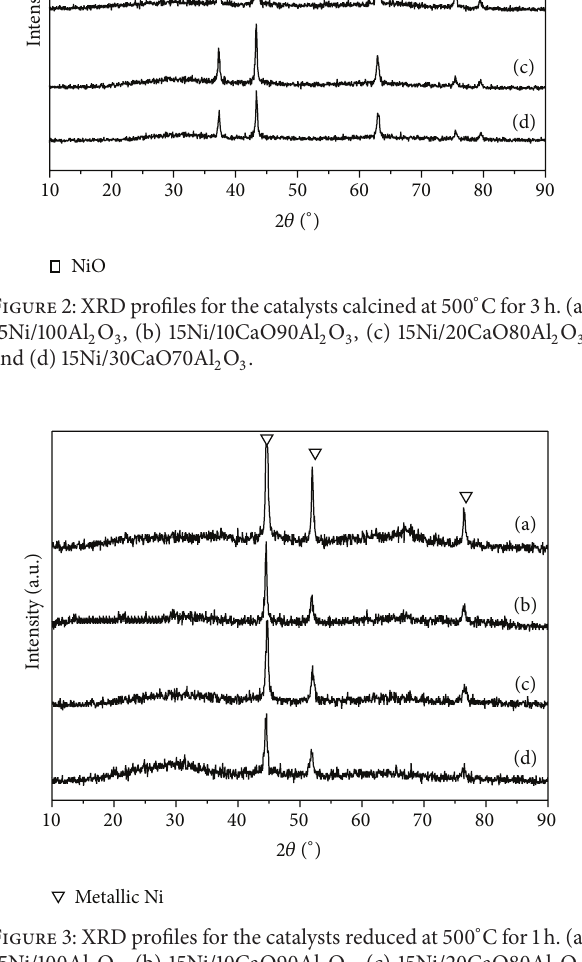
Figure 3: XRD profiles for the catalysts reduced at 500 ∘ C for 1h. (a) 15Ni/100Al 2 O 3 , (b) 15Ni/10CaO90Al 2 O 3 , (c) 15Ni/20CaO80Al 2 O 3 , and (d) 15Ni/30CaO70Al 2 O 3 .